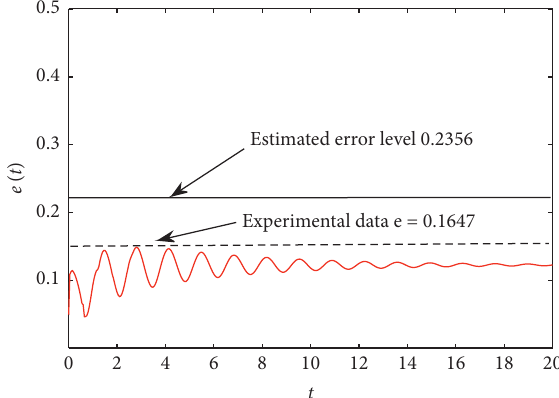
Figure 4: The synchronization error ‖ e ( t )‖ when μ